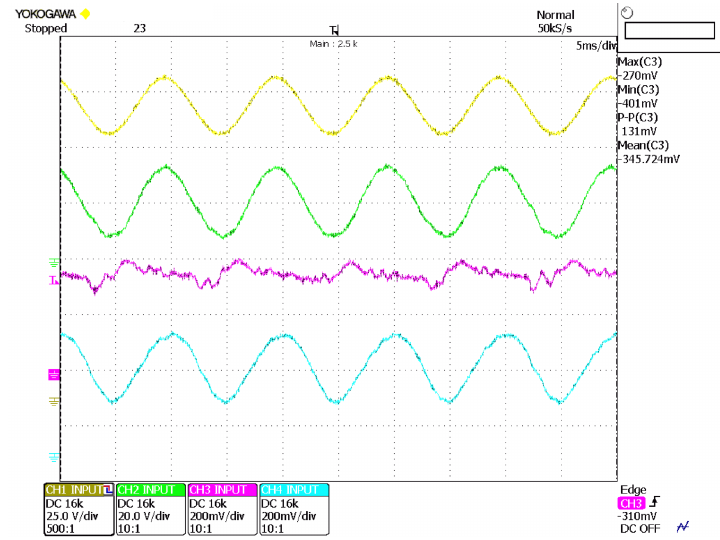
Figure 13. Experimental results of the closed-loop system (5 ms/ div ). CH1 (yellow): u link (25 V/ div ). CH2 (green): u Cs , (20 V/ div ). CH3 (magenta): I LEDs (200 mA/ div ). CH4 (blue): I Lsto (200 mA/ div